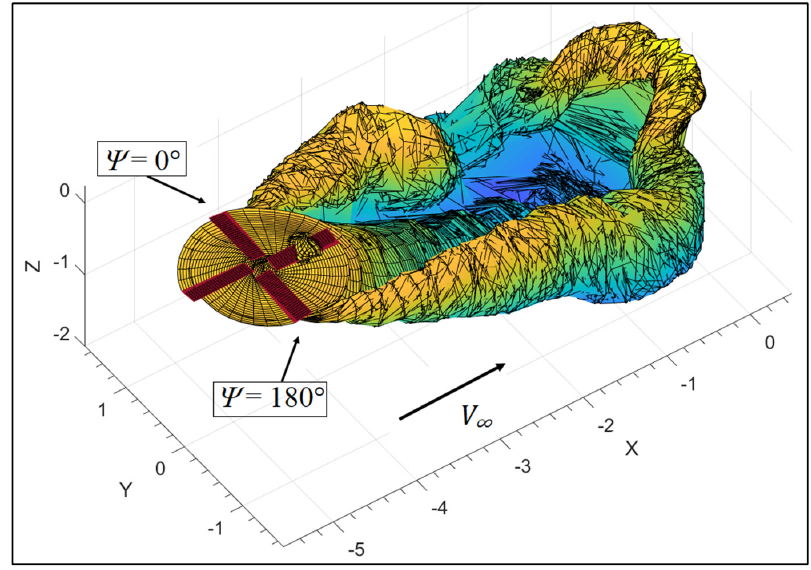
Figure 21. View of the asymmetric wake produced by the four-blade rotor in forward flight.